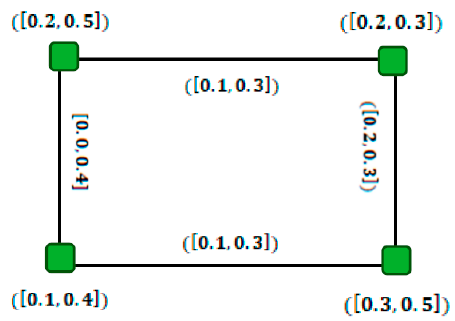
Figure 8. Interval-valued fuzzy graph.